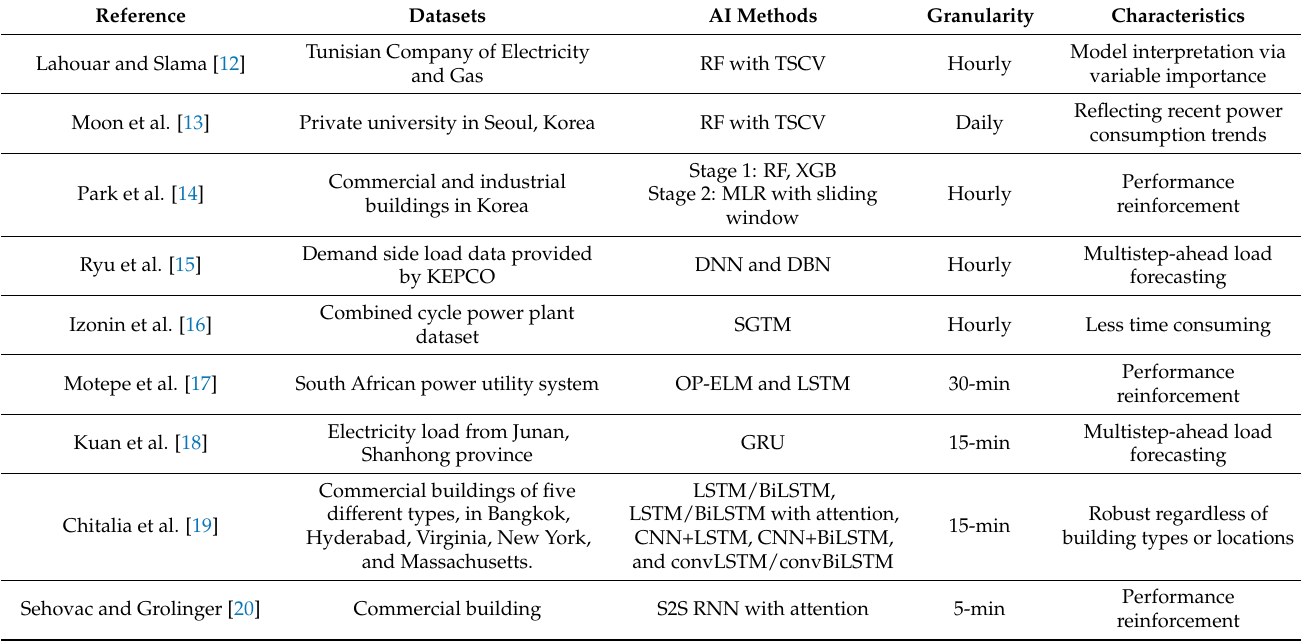
Table 1. Summary of related works (RF, random forest; TSCV, time-series cross-validation; XGB, extreme gradient boosting; MLR, multiple linear regression; KEPCO, Korea Electric Power Corporation; DNN, deep neural network, DBN, deep belief network; SBTM, successive geometric transformations model; OP-ELM, optimally pruned extreme learning machines; LSTM, long short-term memory; GRU, gated recurrent unit; BiLSTM, bidirectional long short-term memory; CNN, convolution neural network; S2S, sequence to sequence; RNN, recurrent neural